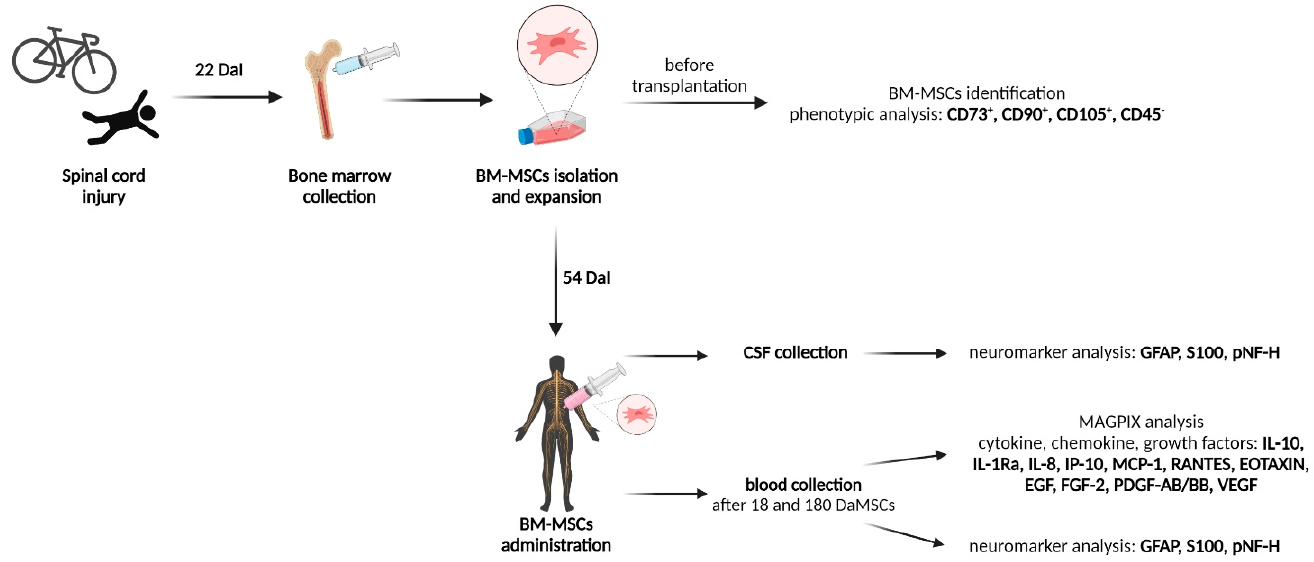
Figure 1. Schematic overview of the course of autologous bone marrow-derived mesenchymal stem cells (BM-MSCs) therapy in a patient with an injured spinal cord. DaI—Days after Injury, DaMSCs—Days after BM-MSCs transplantation. (Created with BioRender.com).